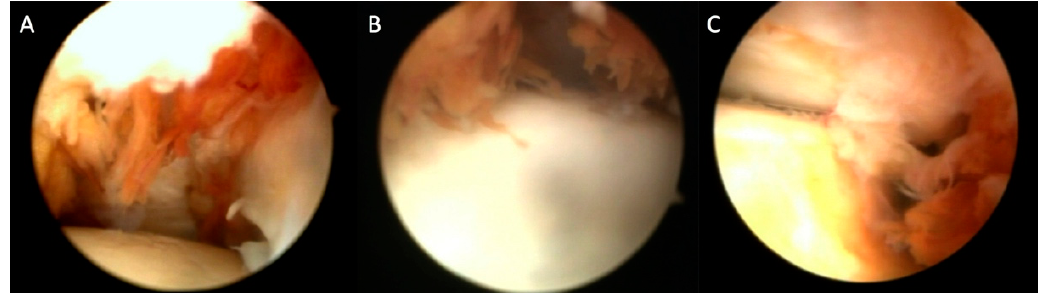
Figure 1. Arthroscopic image of pigmented villonodular synovitis (PVNS) of the ankle joint (( A , B ) anterior arthroscopy; ( C ) posterior ankle arthroscopy) showing the villonodular tissue originating from the synovium.